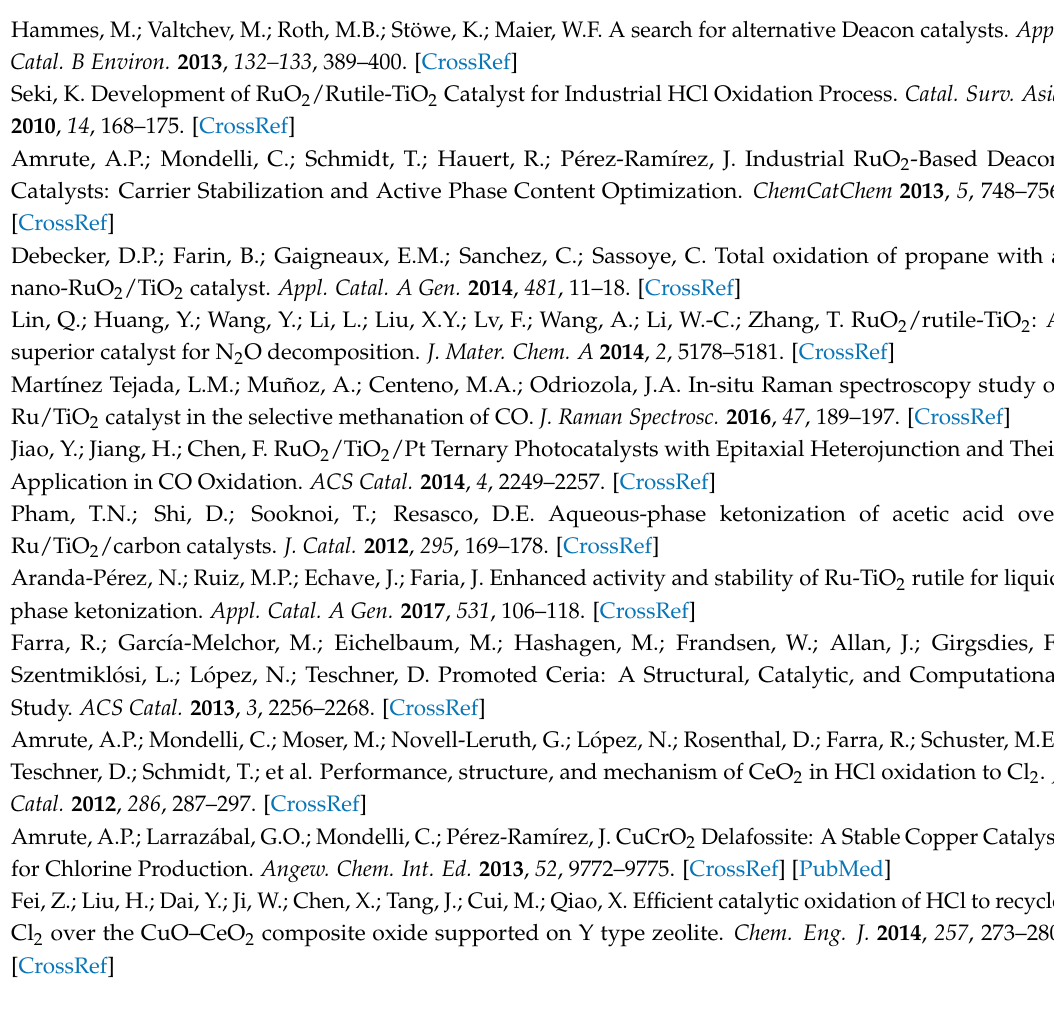
Figure S1: XRD patterns of the self-made RuO 2 and the corresponding intensity line in red from PDF 65-2824, Figure S2: H 2 -TPR profiles of the pure TiO 2 in rutile and anatase, Figure S3: XPS profiles of Ti 2p for RuO 2 /TiO 2 -r with 0.3, 0.5, and 1.0 wt% Ru, Figure S4: XPS spectra of Ce 3d for Ru-Ce/Ti oxide catalysts, Figure S5: XPS spectra of O 1s for the supported RuO 2 and Ru-Ce/Ti oxide catalysts, Table S1: Chemisorbed oxygen (O α ) in the supported RuO 2 and Ru-Ce/Ti oxide catalysts, Figure S6: Raman spectra of the supported RuO 2 and Ru-Ce/Ti oxide